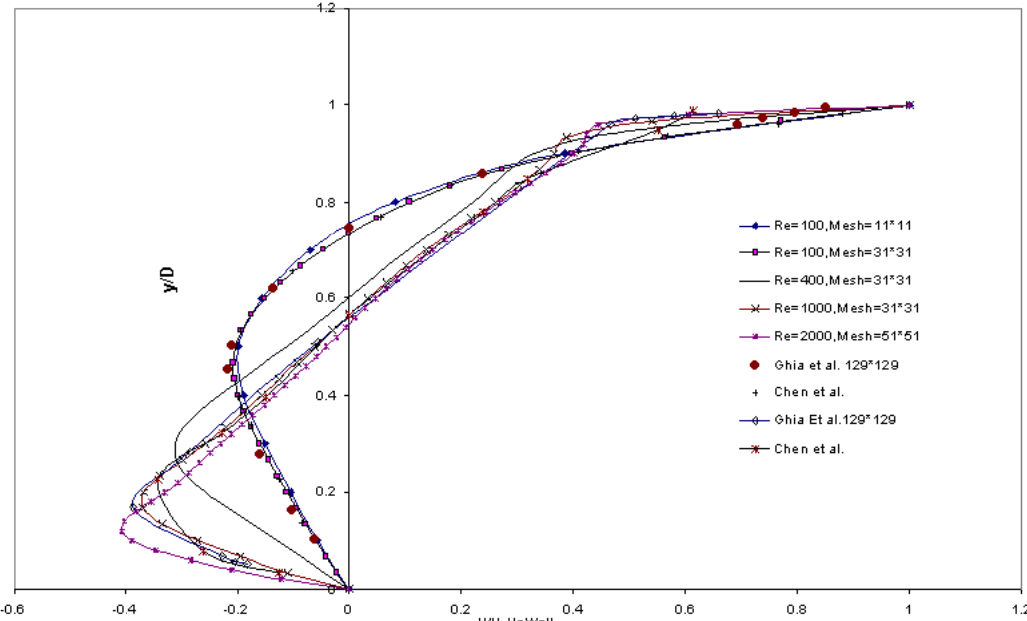
Figure 9. Comparison of vertical component of velocity distribution in x=L/2 with Ghia & Chen